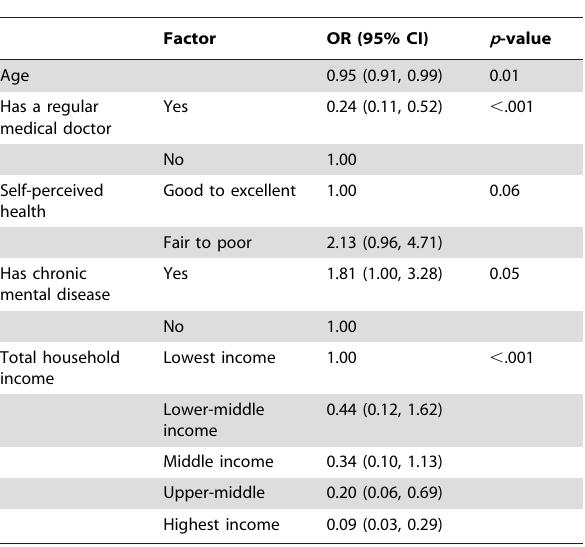
Table 3. Weighed multivariable logistic